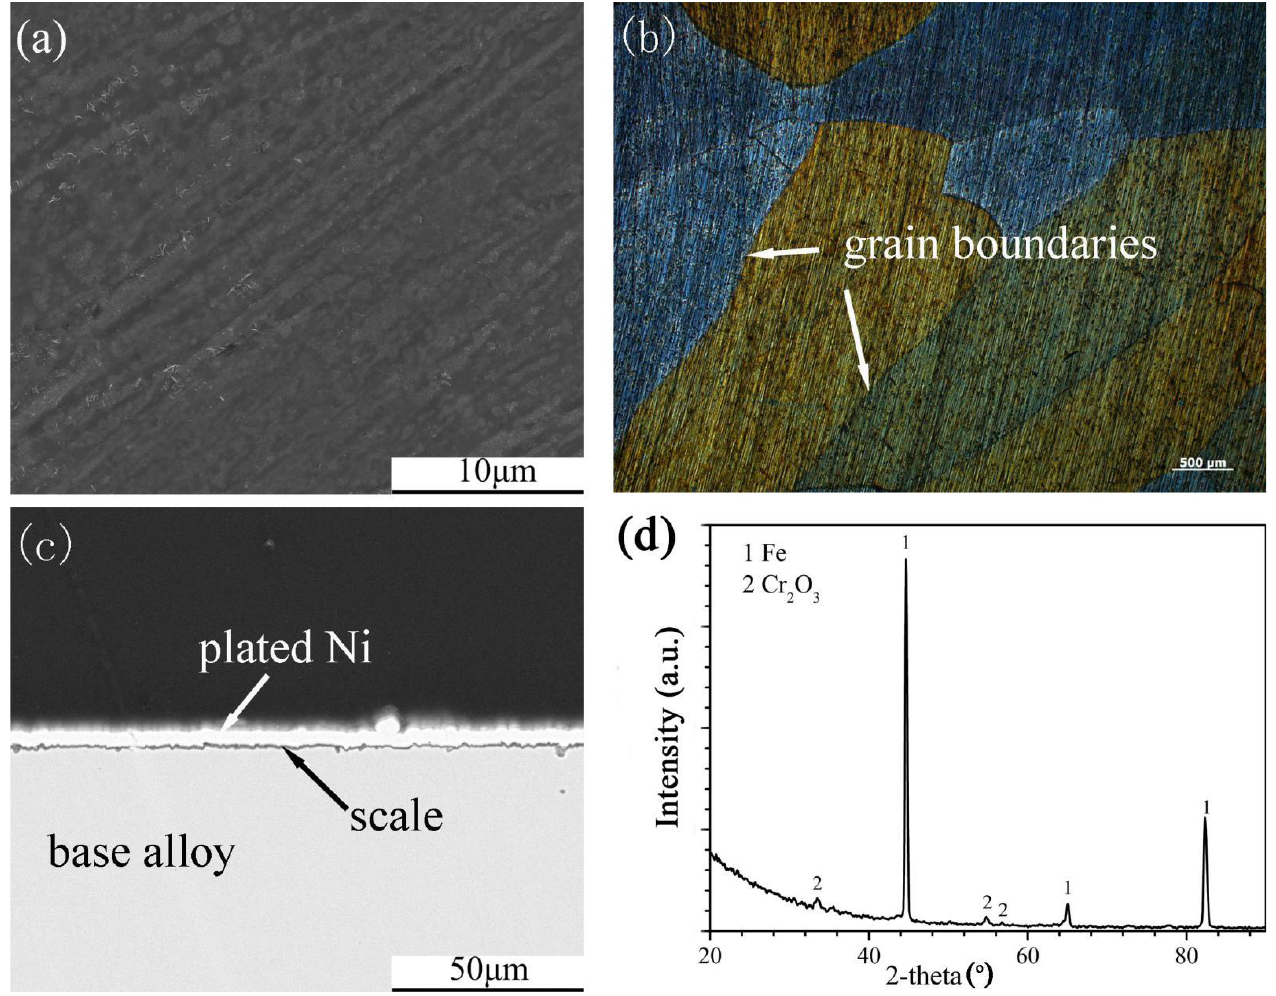
Figure 5. Surface morphology: ( a ) SEM, ( b ) OM, cross-sectional image: ( c ) SEM and XRD spectrum ( d ) of Fe-10Cr-5Si alloy oxidized in H 2 -CO 2 mixture at 600 °C for 24 h.